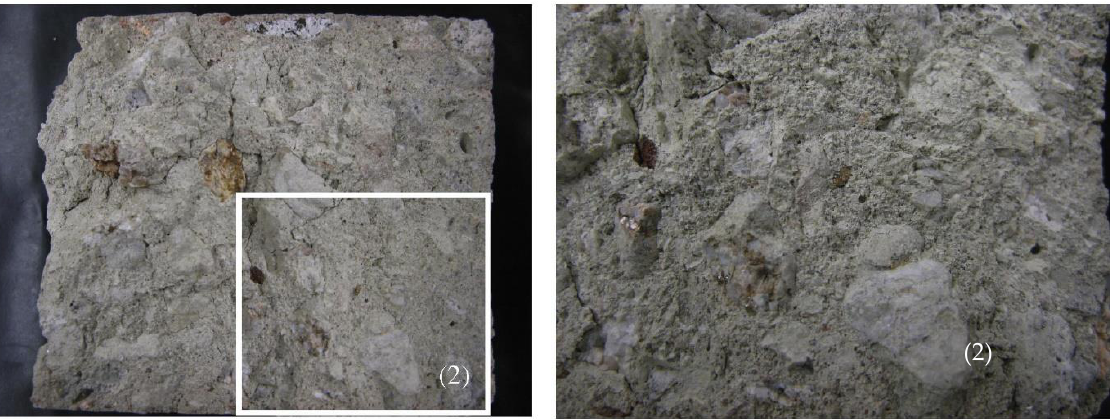
Figure 3. Interior surface of typical recycled concrete exposed to elevated temperature at 800 °C for 4 h. Copyright permission is taken from [79].